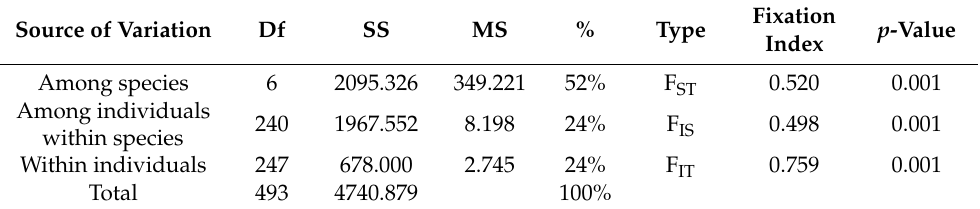
Fixation p -Value Index